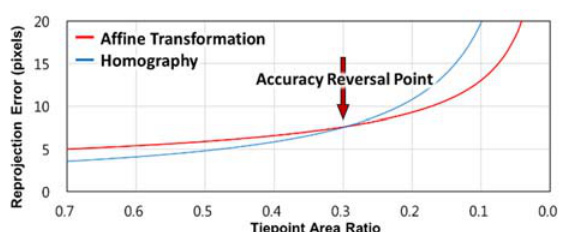
Figure 2. Comparison of correlation models established between transformation accuracy and tiepoint area ratio.